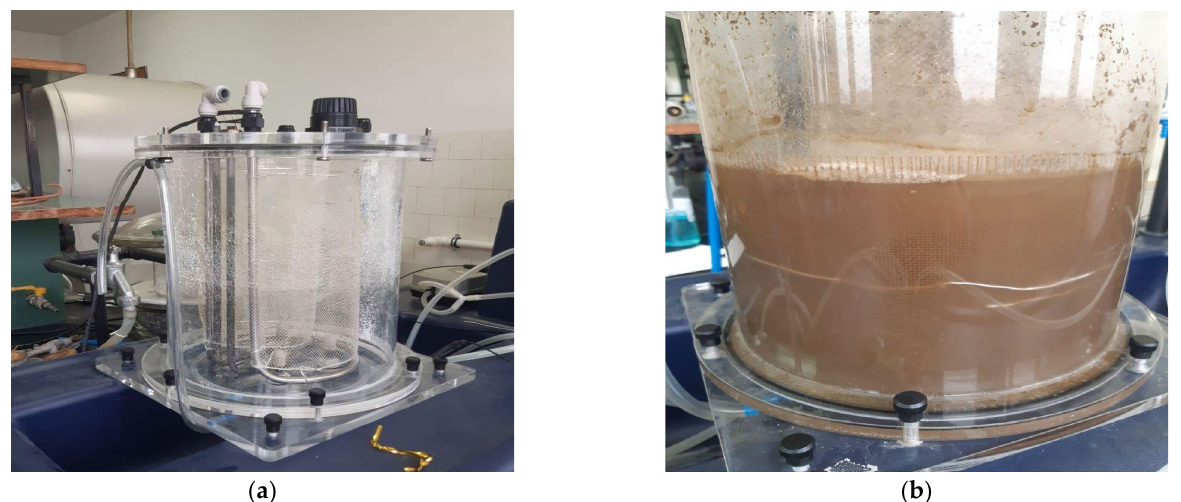
Figure 3. ( a ) Net installation in the bioreactor before the wastewater treatment during the main experiment. ( b ) Wastewater in the bioreactor on the 1st day of treatment during the main experiment.